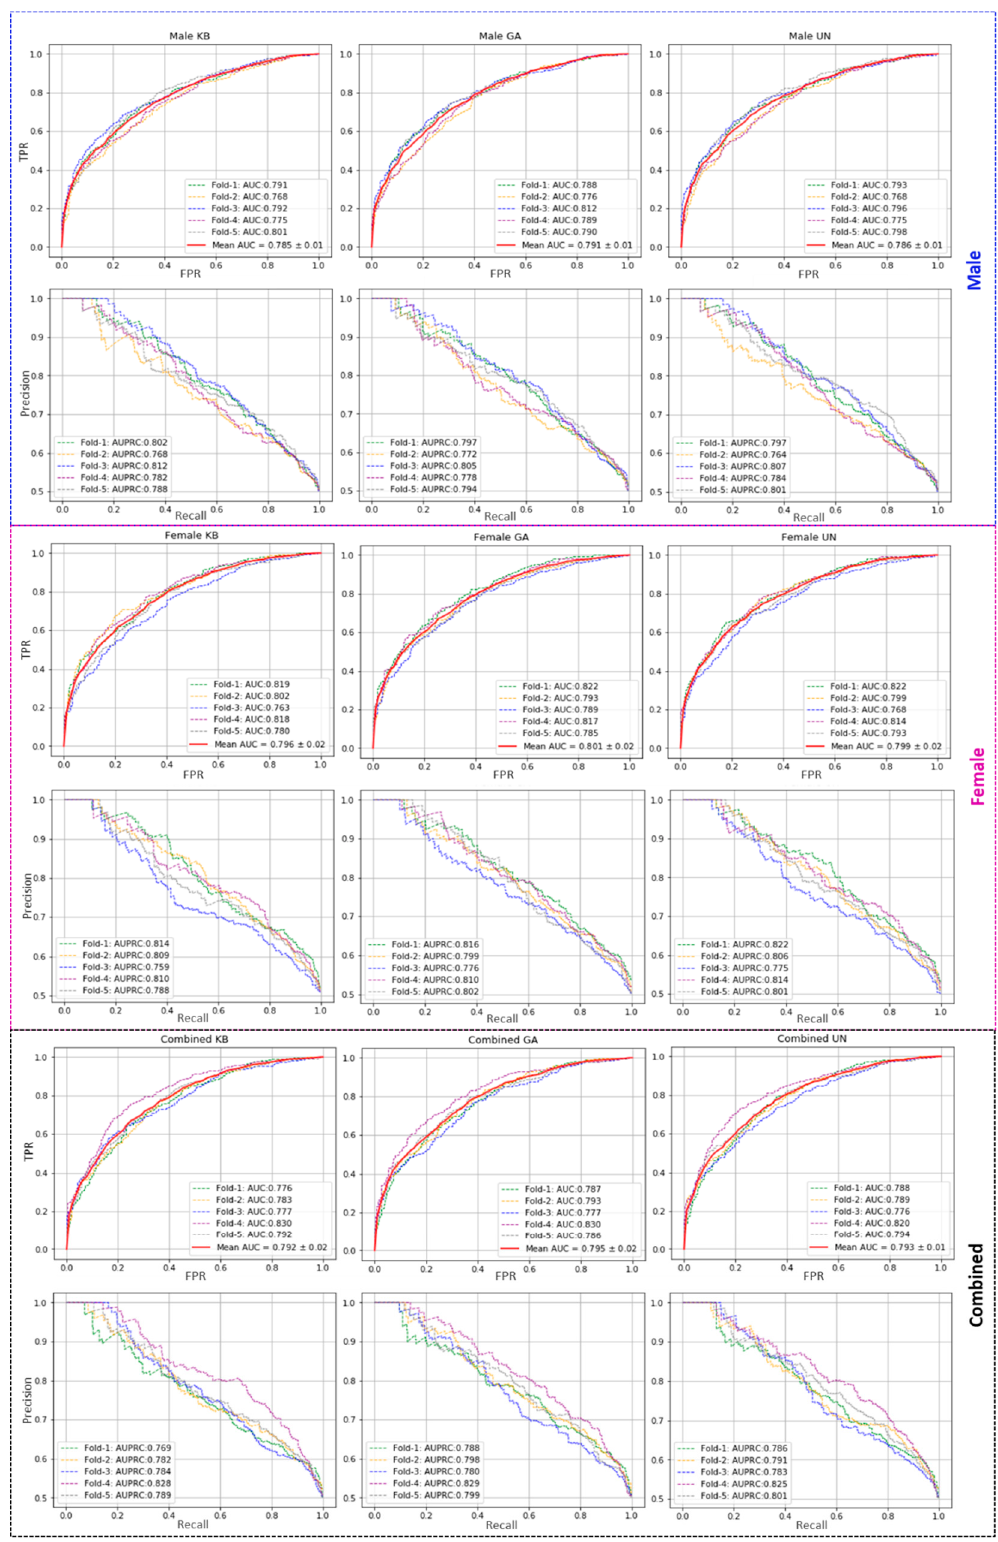
Figure 1. Performance evaluation on three datasets, Male, Female, and Combined. Plots in the 1st, 3rd, and 5th rows show the AUC, and the 2nd, 4th, and 6th rows represent AUPRC, respectively. The 1st, 2nd, and 3rd column-wise plots represent KB, GA, and UN type features-based evaluation.